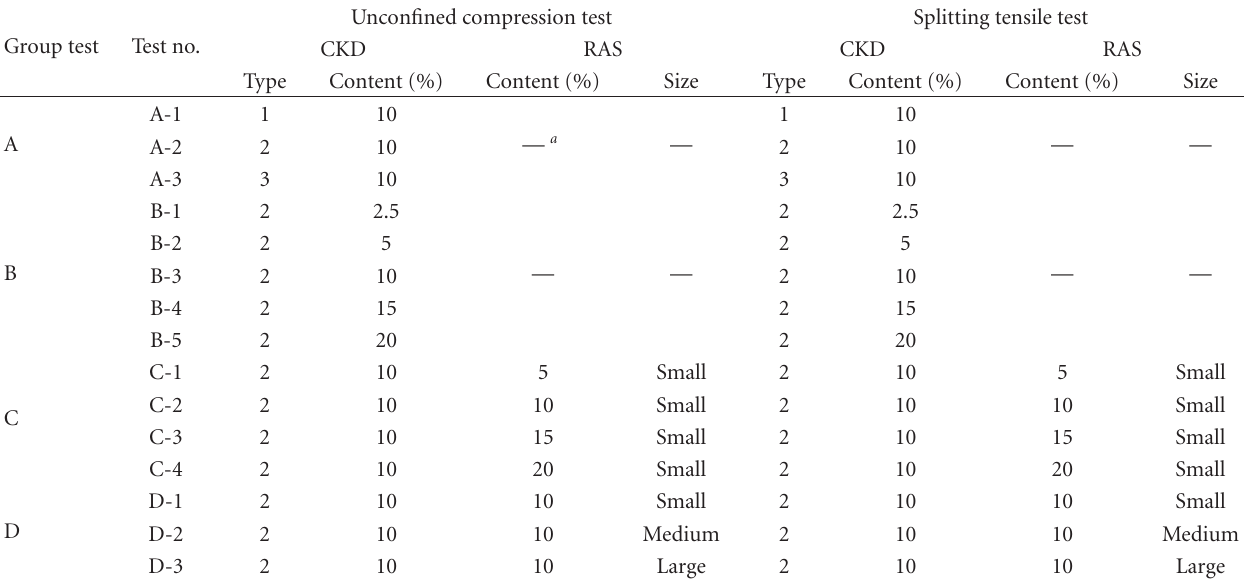
Table 3: Experimental